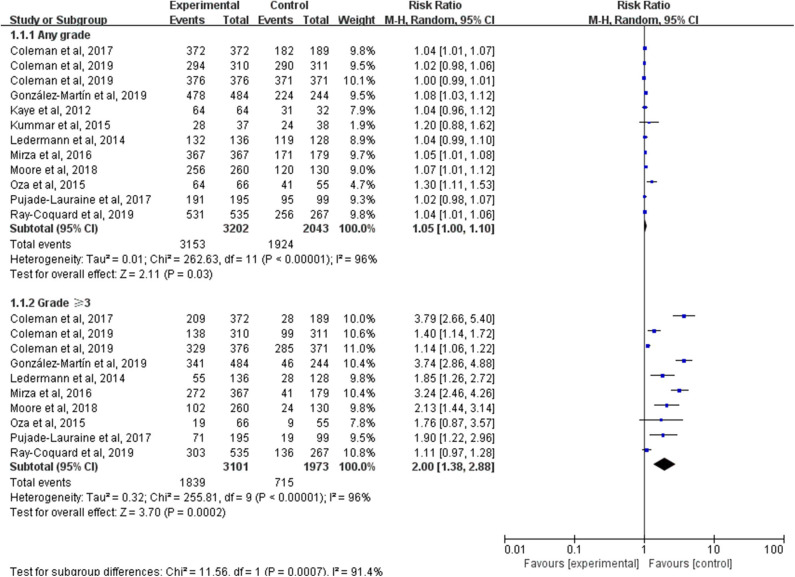
Forest plot of risk ratios (RRs) comparing adverse events (AEs) of any grade or grade 3 or higher in patients treated with PARP inhibitors vs. placebo or chemotherapy.